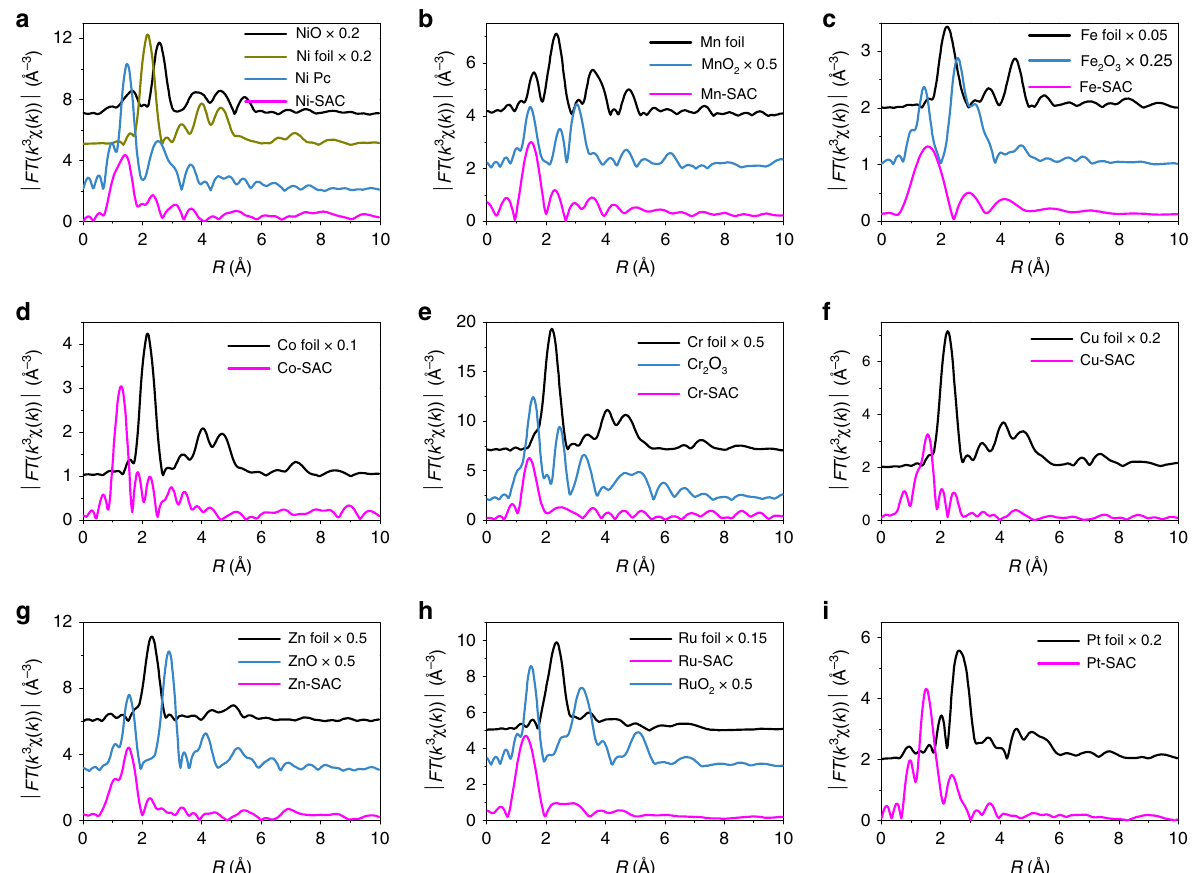
Fig. 4 Metal K -edge extended X-ray absorption fi ne structure ( R space plots). a Ni-SAC, b Mn-SAC, c Fe-SAC, d Co-SAC, e Cr-SAC, f Cu-SAC, g Zn-SAC, h Ru-SAC, and i Pt-SAC. In all the M-SACs, the metal atoms existed as isolated M 2 + centers in a MN 4 coordination